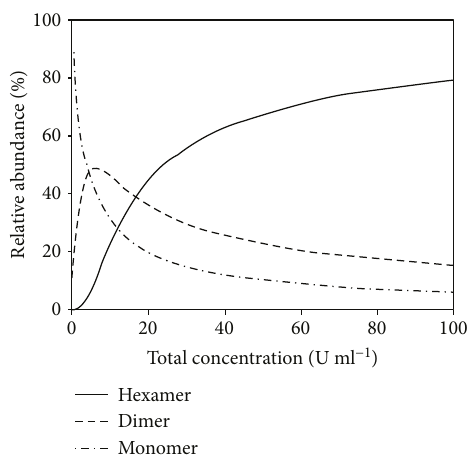
Figure 3: Relative abundance (%) of insulin hexamers, dimers, and monomers as a function of total concentration C τ . Printed with permission from Elsevier and Søeborg: Absorption kinetics of insulin after subcutaneous administration. Eur J Pharm Sci (2009) 36: 78 – 90. © 2009